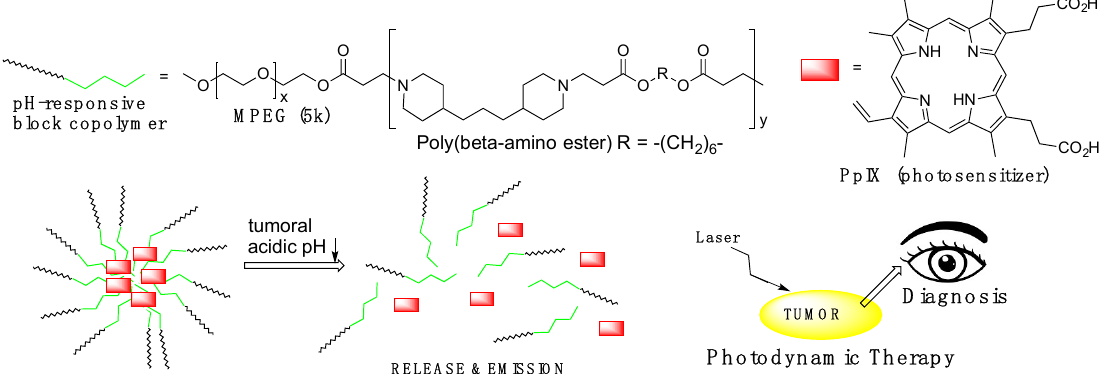
Figure 2. Schematic illustration of the micellization and demicellization processes of protoporphyrin IX (PpIX)-pH-responsive polymeric micelles (pH-PMs) and simultaneous tumor photodiagnosis and photodynamic therapy in vivo.